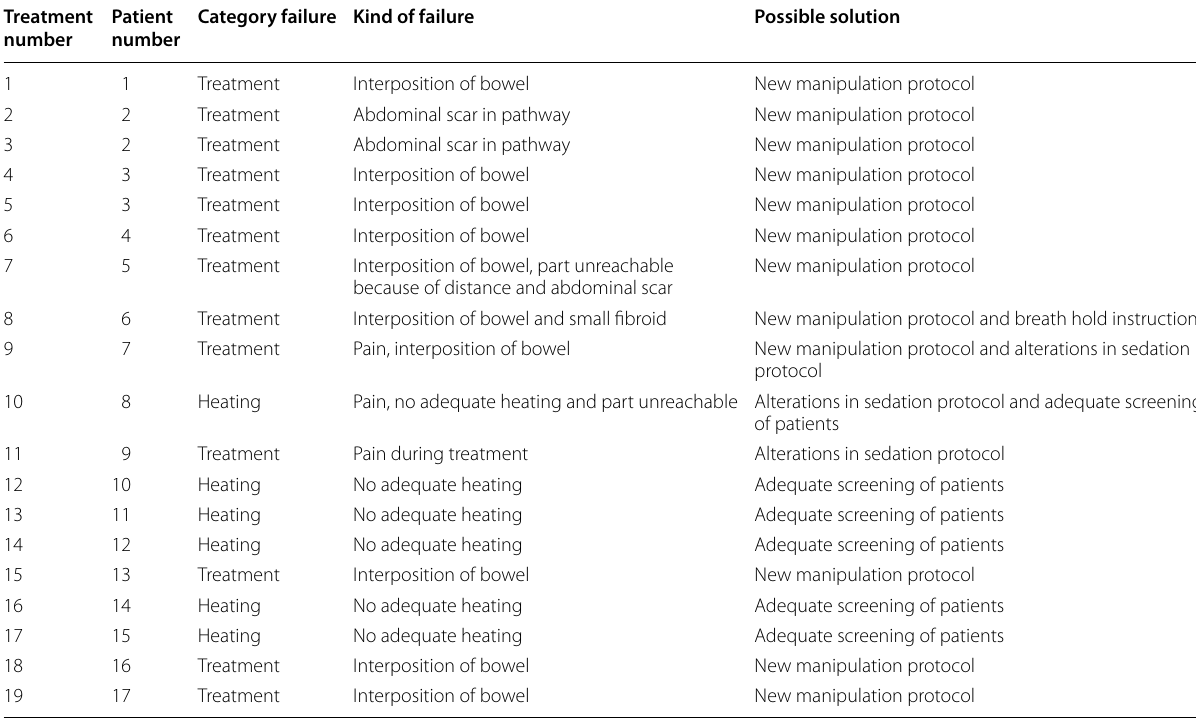
Table 5 Overview of failed treatments, reason of failure and possible solution Treatment